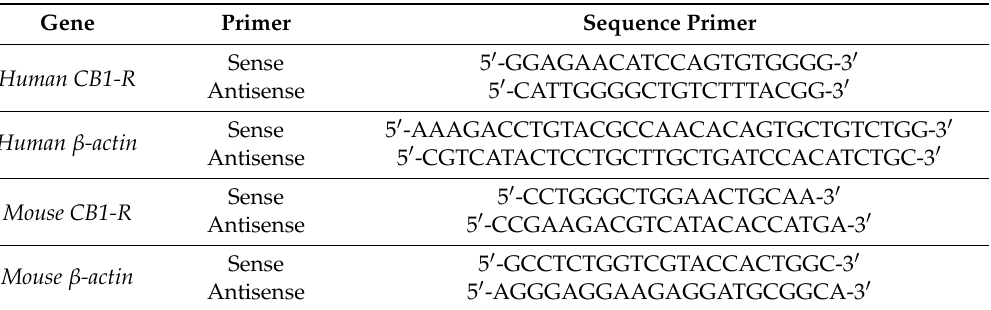
Table 2. Sequences of